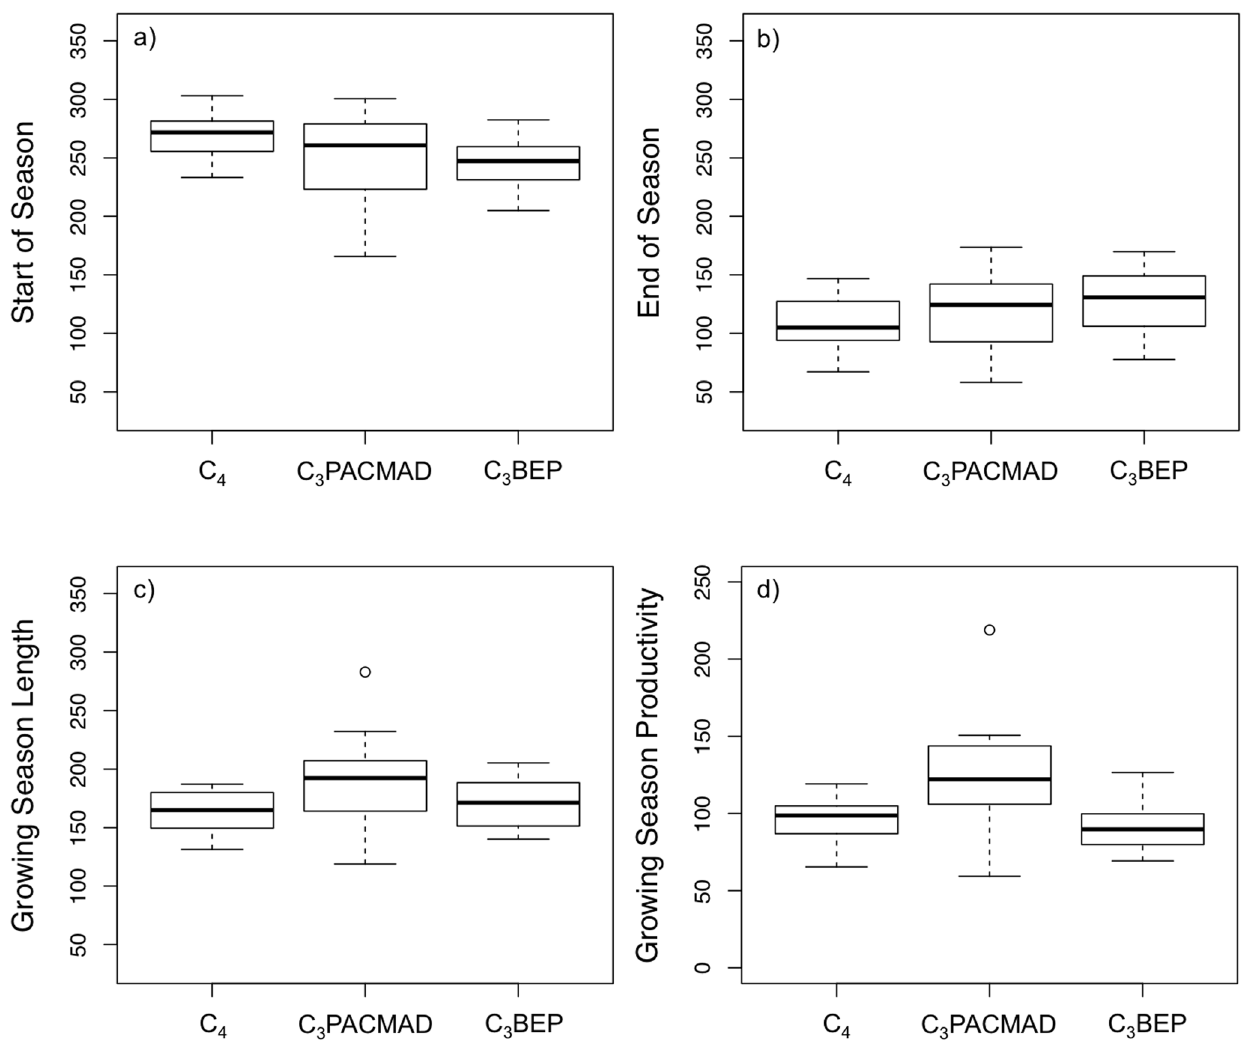
Figure 1. Differences in C 3 and C 4 start-of-season (SOS) (a), end-of-season (EOS) (b), growing season length (c), and growing season productivity (d). Y-axis for panels (a)–(c) is the Julian day-of-year or DOY; y-axis for panel (d) is integrated NDVI, which is unitless, based on logistic models using 10-year timeseries of MODIS NDVI (see Methods). The growing season in Hawaii crosses the calendar year so that SOS begins at a later DOY than EOS. Most Poaceae species fall within the ‘BEP’ or ‘PACMAD’ clade. All C 4 grasses are in the ‘PACMAD’